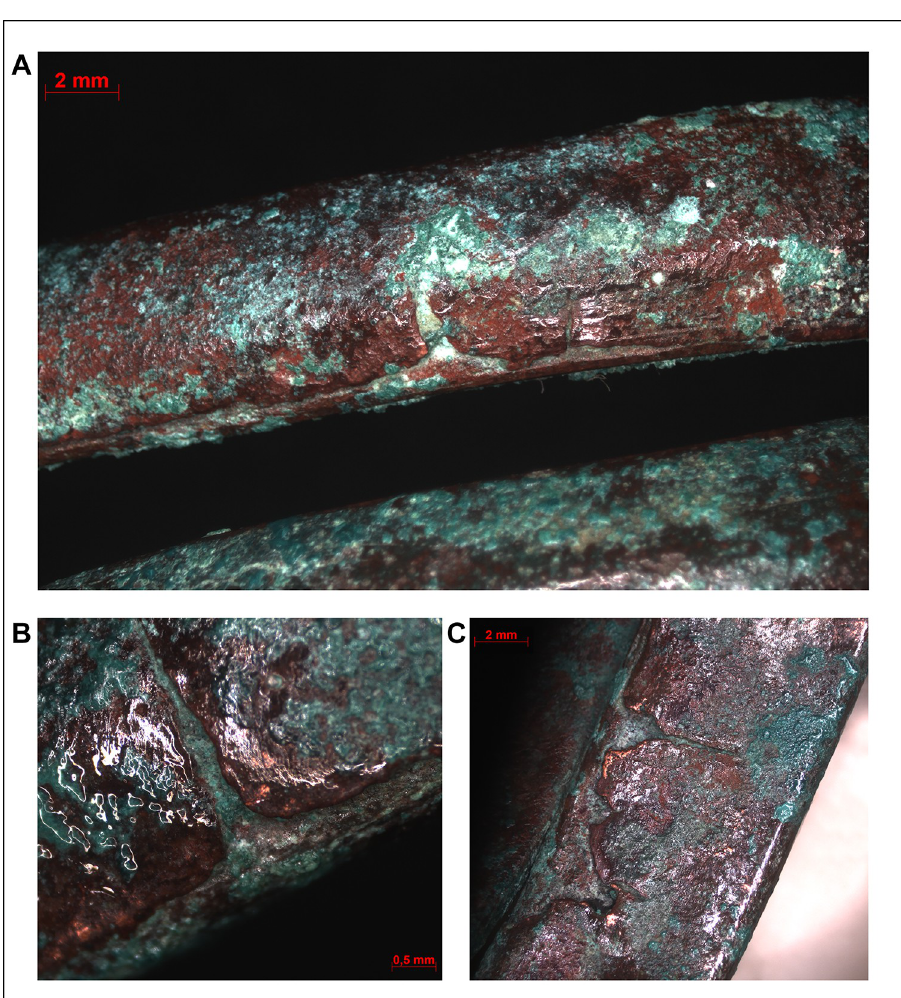
Fig 17. Micrographs showing the macrostructure of spiral bracelets. Photo: Eszter Horva´th. (A–B) Cracks on the outer surface of the spiral coil segment of the intact bracelet (O˝.2019.8.1.243.). (C) Cracks on the inner surface of the spiral coil segments of the bracelet cut in half